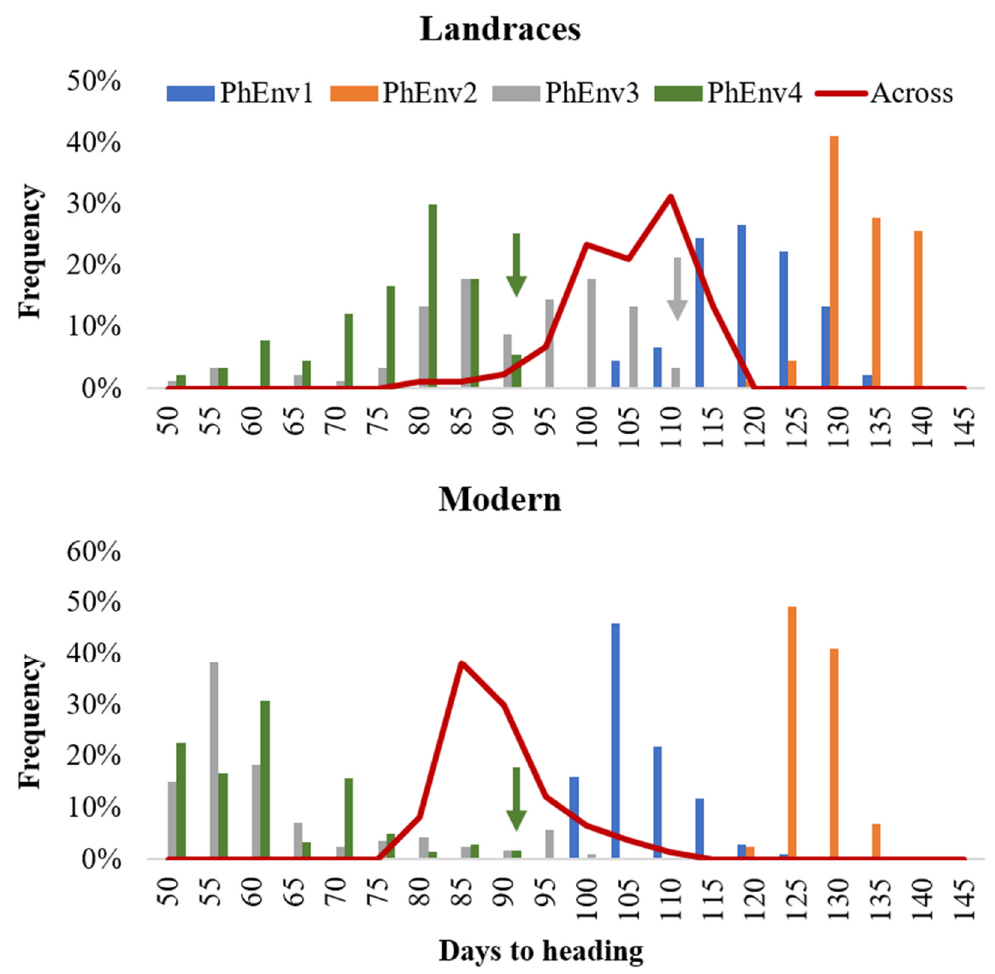
Figure 3. Distribution of 384 durum lines for days to heading in each pheno-environment (PhEnv) expressed as bars, combined across environments expressed as a red line, and divided for landraces and modern germplasm. The color-coded arrows indicate germplasm that did not flower in PhEnv3 or PhEnv4, to which was assigned the maximum value to be used for association studies.